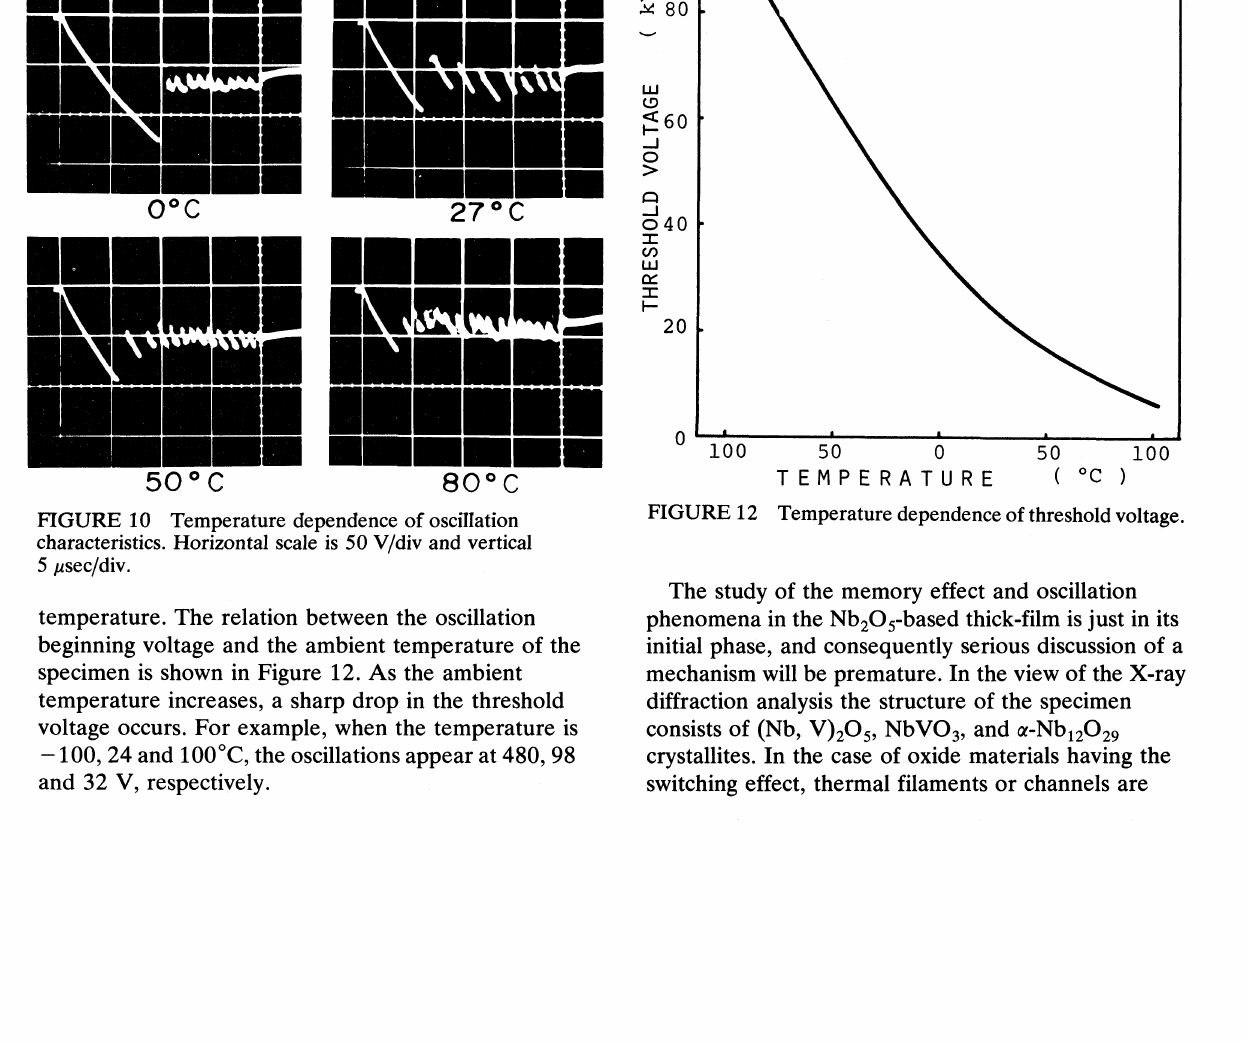
FIGURE 9 Relation between applied voltage and backward switch time.